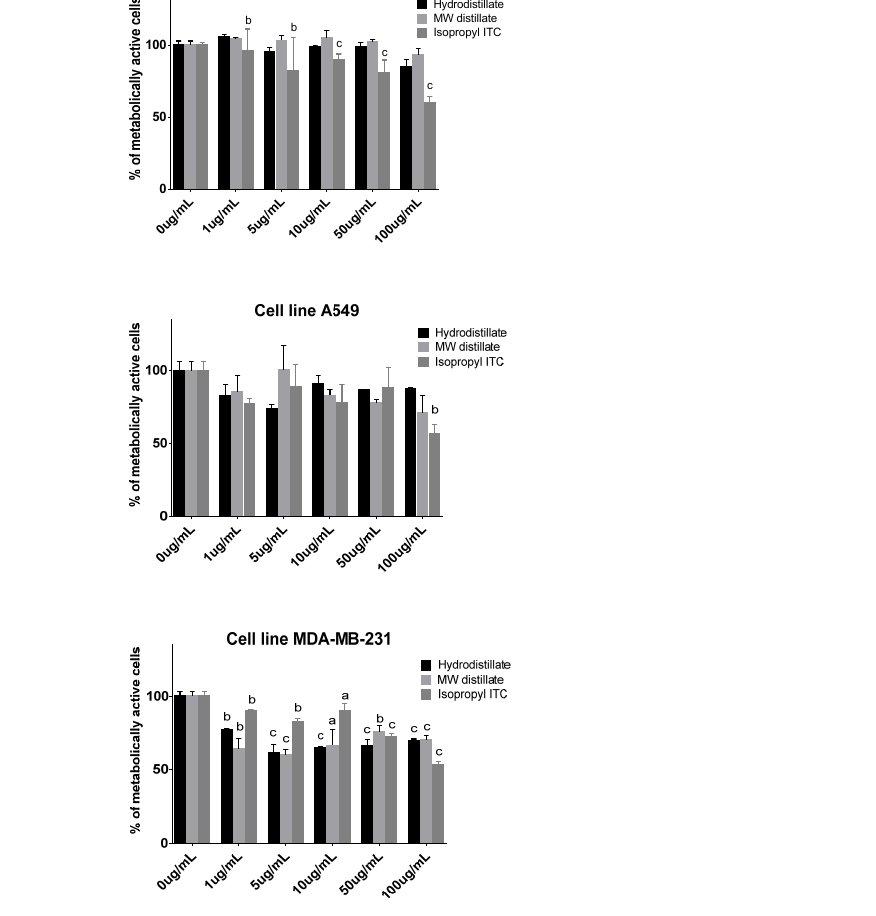
Figure 2. Percentage of metabolically active human lung cell lines A549, human bladder cell line T24, and human breast cell line MDA-MB-231 for different concentrations of S. officinale hydrodistillation and microwave-assisted distillation, as well as isopropyl isothiocyanate. Each data point is presented as the mean ± SD ( n = 3). Lower case letters represent significance level in comparison to non-treated cell line samples (a, p < 0.05; b, p < 0.01; c, p < 0.001).